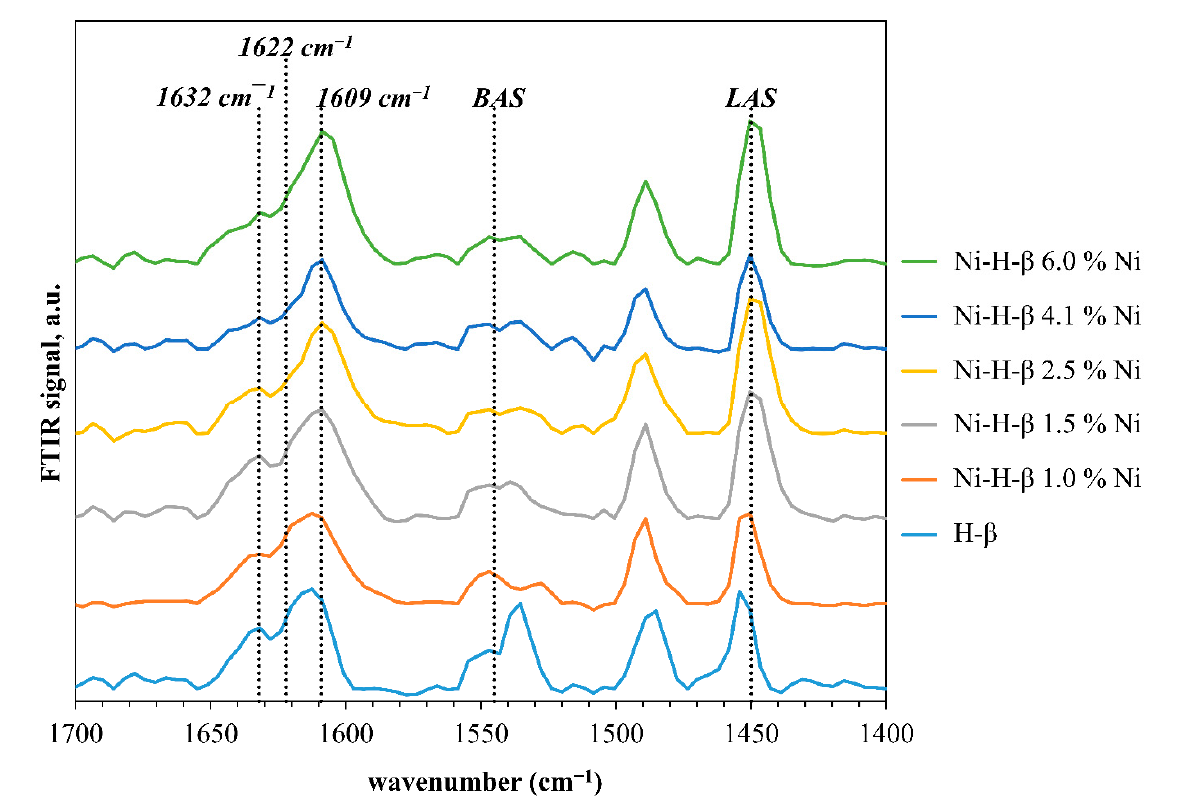
Figure 3. Infrared spectra in the pyridine region after pyridine adsorption over Ni-H-Beta catalysts with different nickel loadings followed by evacuation at 250 °C. LAS = Lewis acid site; and BAS = Brønsted acid site.